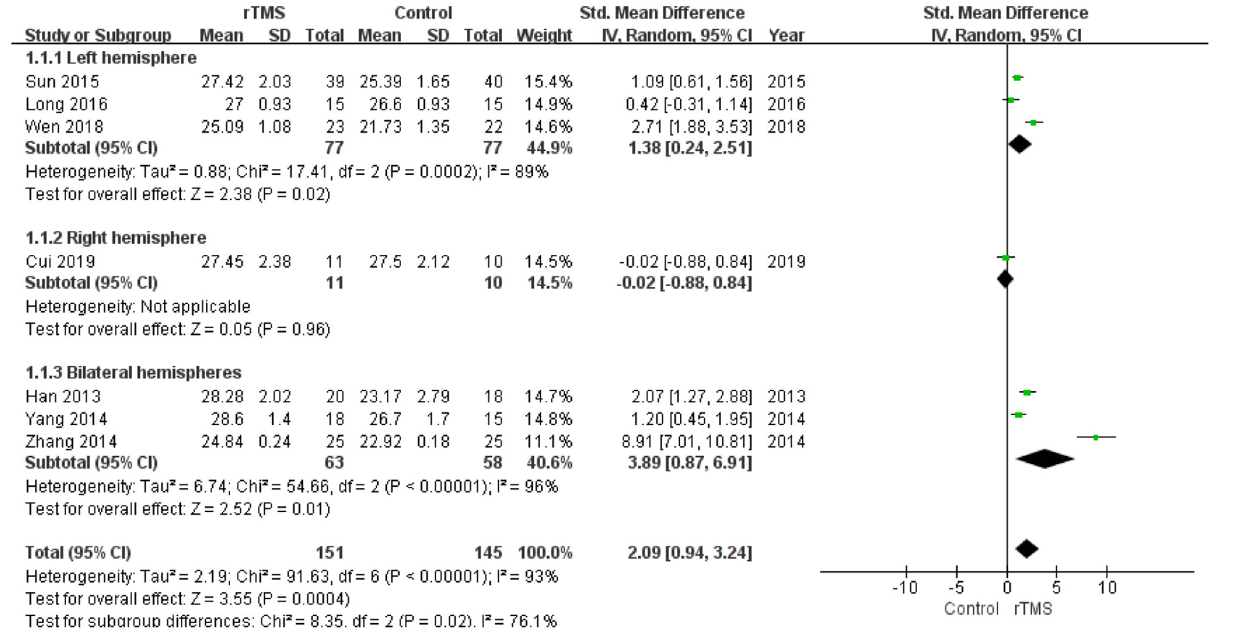
FIGURE 5 | Meta-analysis forest plot of subgroup analysis showing global cognitive function of repetitive transcranial magnetic stimulation group vs. control group in the treatment of mild cognitive impairment: left hemisphere vs. right hemisphere vs. bilateral hemispheres.